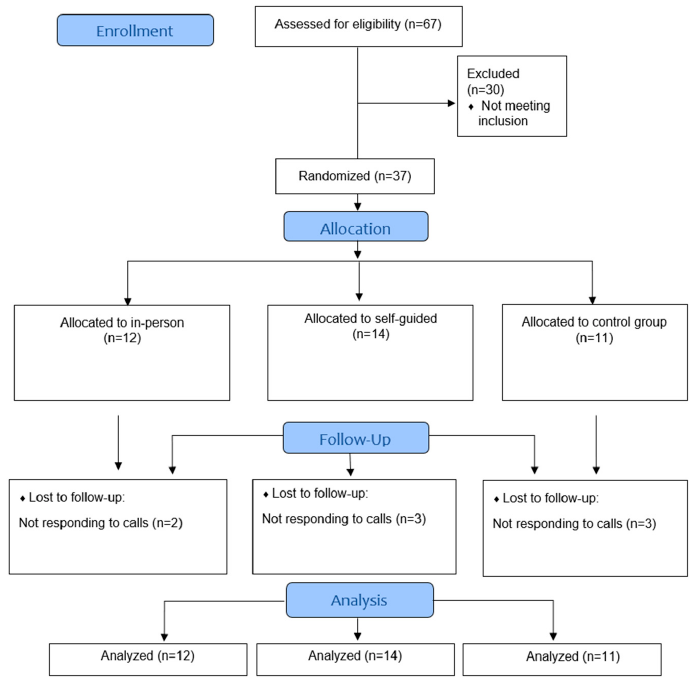
Figure 2. Enrollment flow diagram.